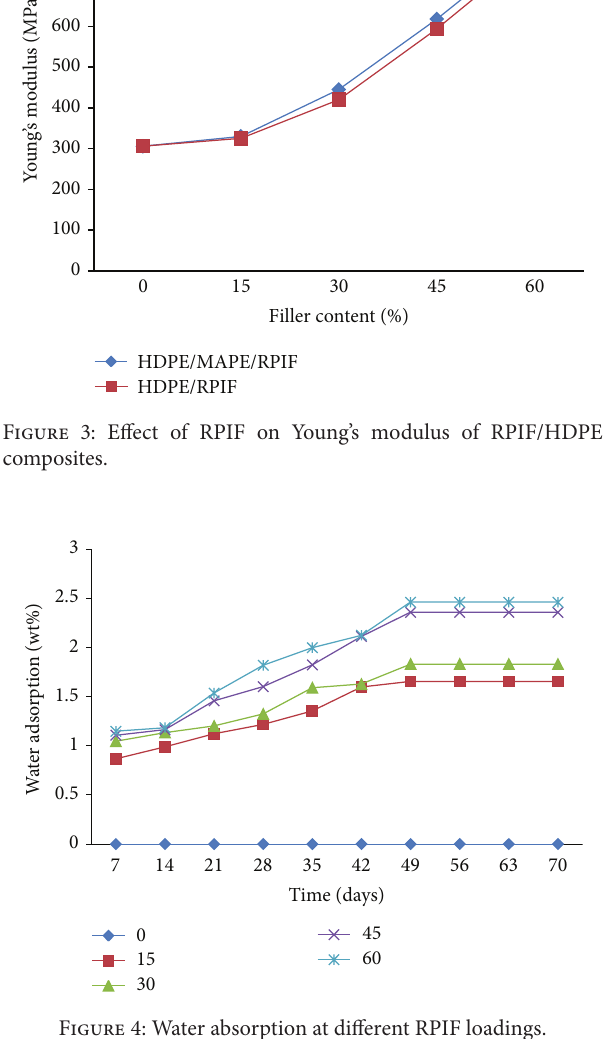
Figure 2: Effect of RPIF on elongation at break of RPIF/HDPE composites.